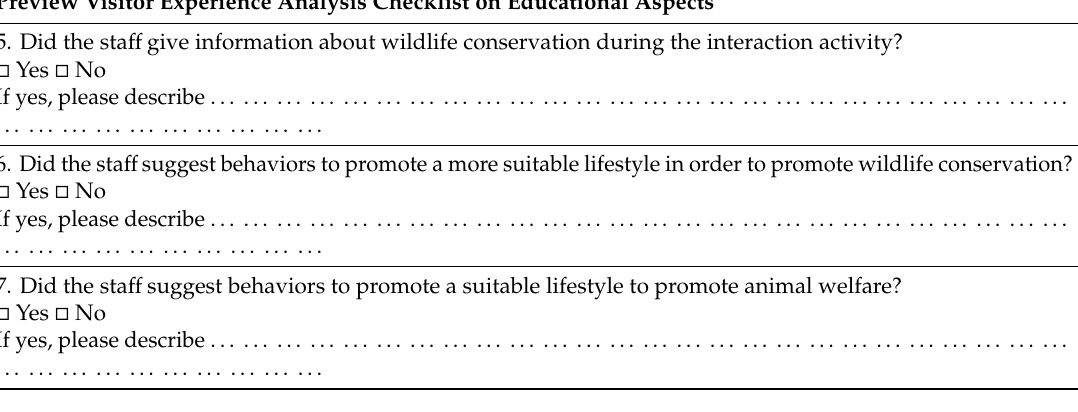
Table A6. Topics in the visitor experience survey among the three versions.